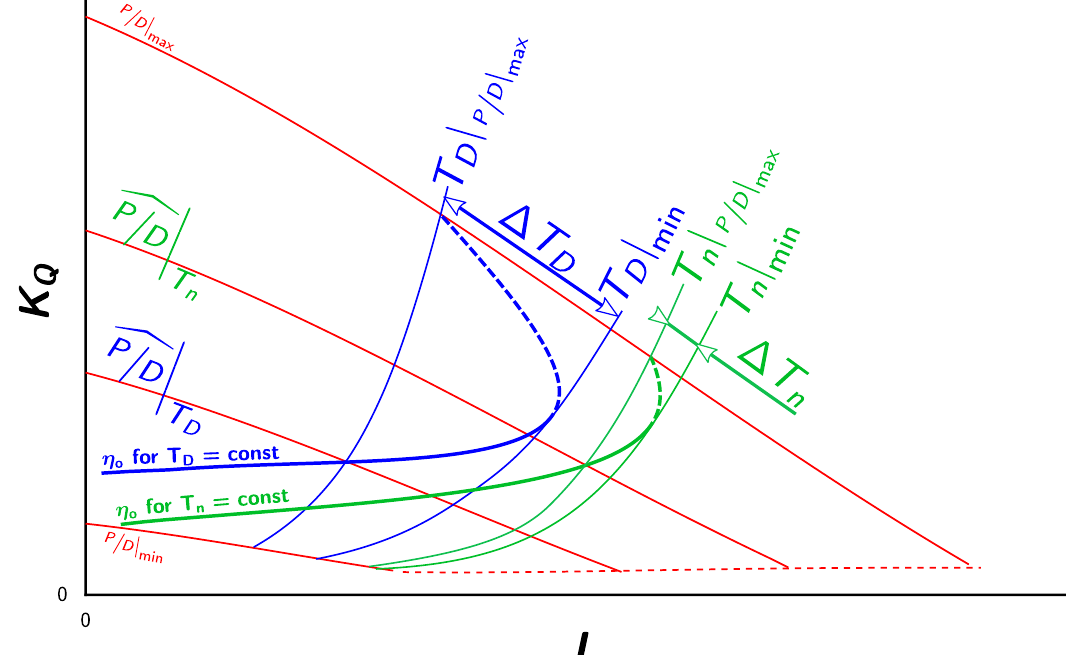
Figure 4. Symbols and definitions used to describe the overlap of the η o , max lines given in Table 2 using the example of the T D and T n curves in the Danckwardt T–J efficiency